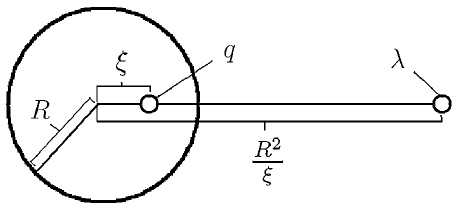
FIG. 17. Diagram of the coordinate system in use for deriving the effects of image charge on the motion of the beam.